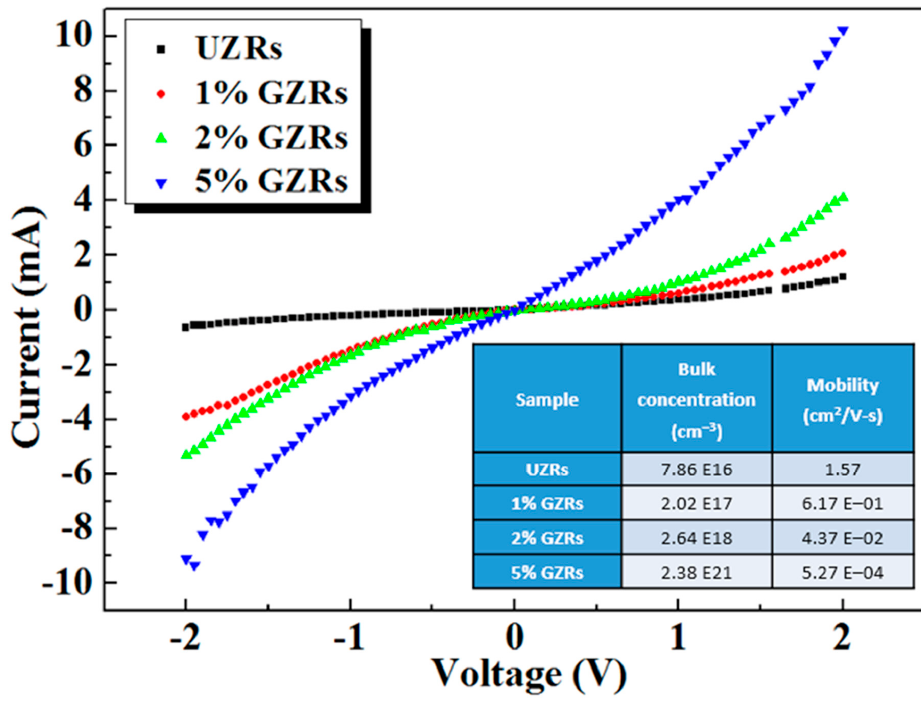
Figure 8. Electrical characteristics of UZRs and GZRs. Bottom inset table reveals the Hall-effect measurements.